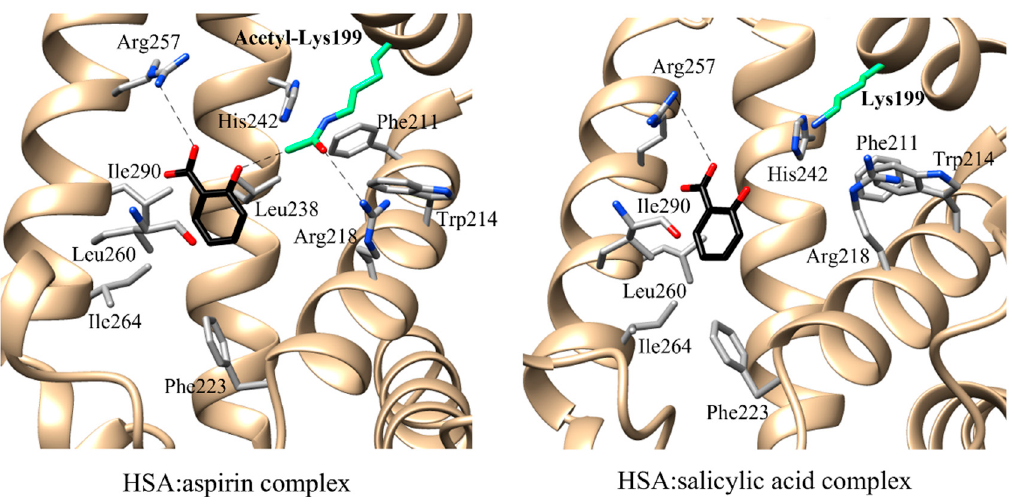
Figure 2. Structural environment of the HSA:aspirin complex (PDB ID: 2I2Z) [97] and of the HSA:salicylic acid adduct (PDB ID: 2I30) [97]. Acetyl-Lys199 and Lys199 residues are showed in green. Hydrogen bonds are shown in blue dash lines. Salicylic acid is rendered in sticks (black). Pictures have been drawn with UCSF-Chimera package [45].